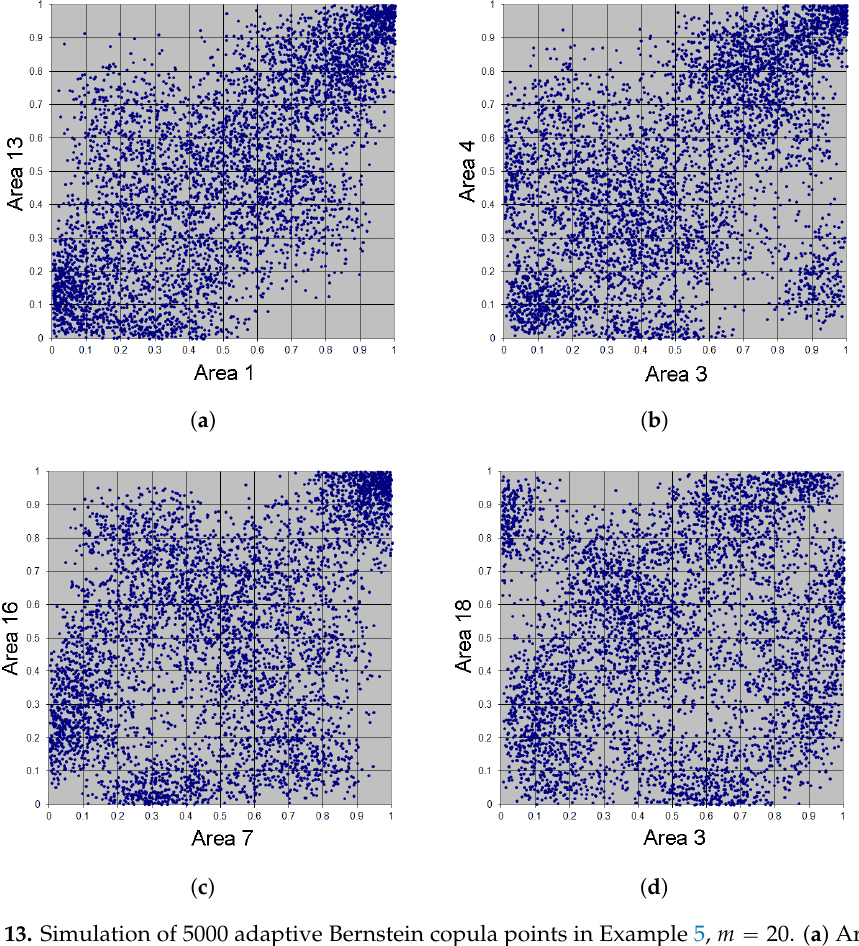
Figure 13. Simulation of 5000 adaptive Bernstein copula points in Example 5, m